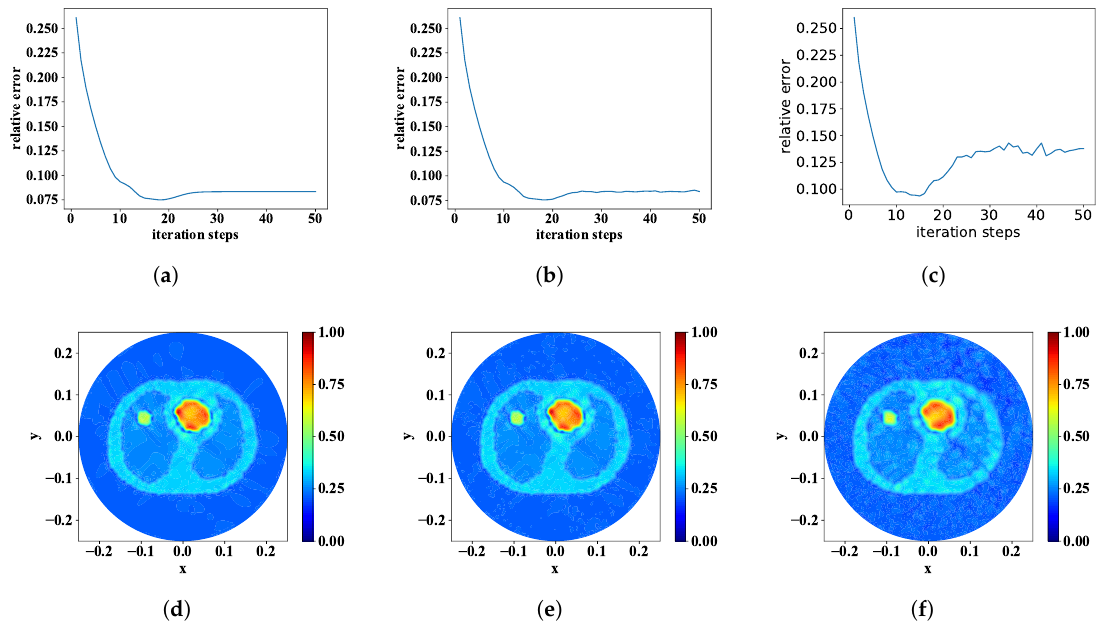
Figure 13. The variation of the relative error for ( a ) SNR = ∞ , ( b ) SNR = 40 dB, and ( c ) SNR = 20 dB. The reconstructed conductivity distribution for ( d ) SNR = ∞ , ( e ) SNR = 40 dB, ( f ) SNR = 20